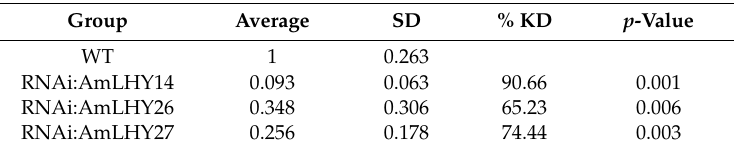
Figure 1. AmLHY expression: ( a ) Daily expression in wild-type plants under a 12 h light / 12 h dark (12LD) cyle; ( b ) AmLHY expression at ZT1.5 in wild-type (red) and transgenic lines RNAi:AmLHY14 (green), RNAi:AmLHY26 (blue) and RNAi:AmLHY27 (purple). Expression was determined by the ∆∆ Ct method using the wild-type as a control. Reference gene was AmUBI . Each bar represents the average ± standard deviation from 3 to 4 biological replicates. Table 1. AmLHY expression in wild-type and RNAi lines at ZT 1.5. Expression was normalized by WT. Average and standard deviation (SD) represents 3 to 4 biological replicates. The knock down percentage in RNAi lines is shown in the % KD column. Differences were tested by a Student’s t-test; a p -value <0.05 indicates a significant down-regulation.